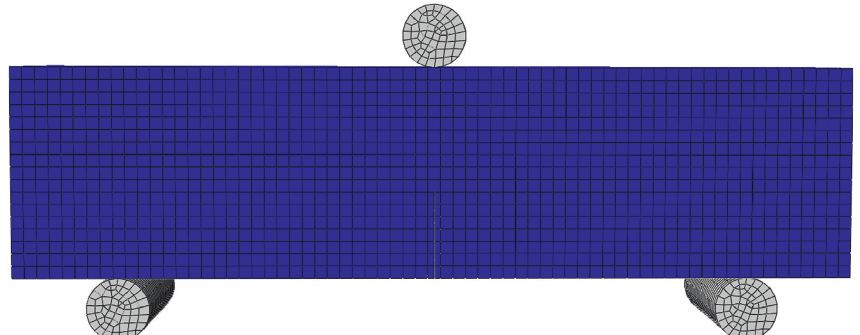
Figure 9: Finite element model of the concrete beams with the notch.